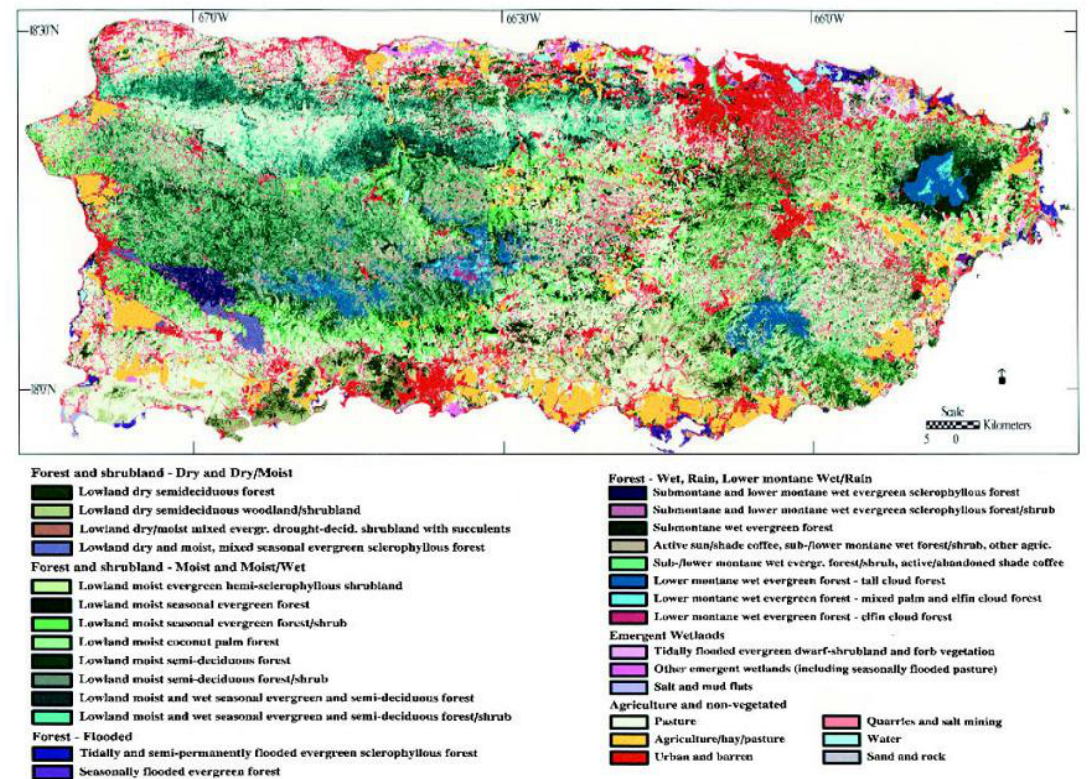
Figure 4. Puerto Rico 1992 Land Cover Map from Helmer et al.